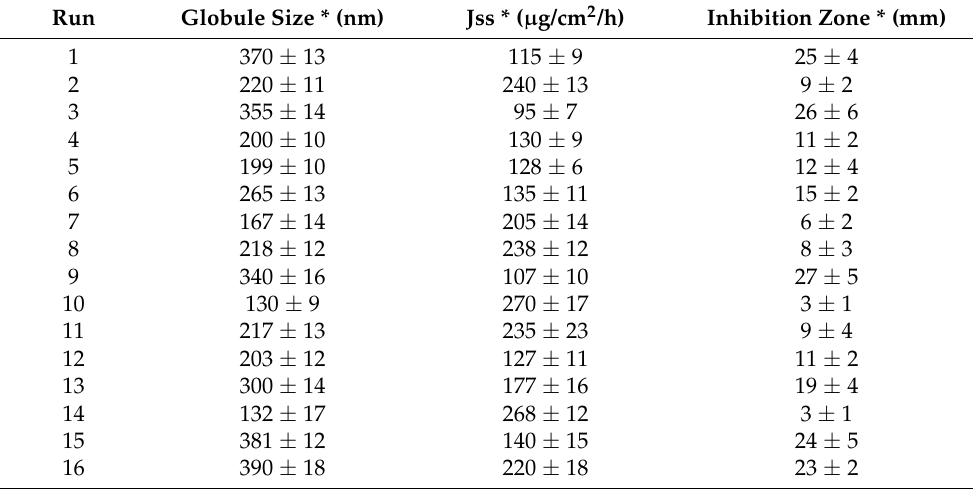
Table 5. Projected trial formulations and their observed responses according to the mixture design.